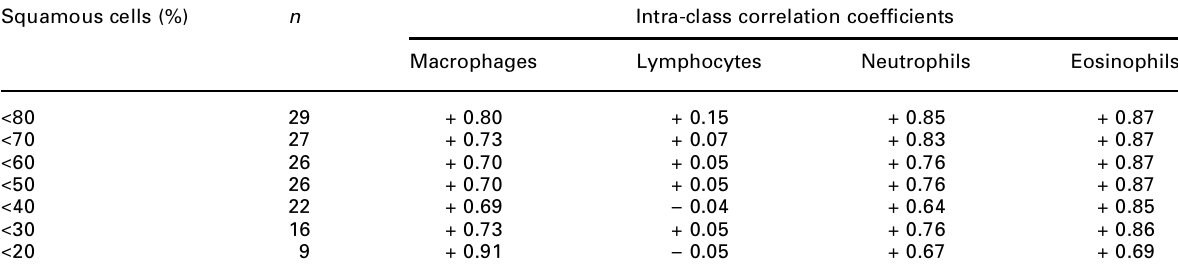
Table 3. Intra-class correlation coefficients for sputum inflammatory cells, calculated for sub-groups selected on the basis of different levels of squamous cell contamination Squamous cells (%)